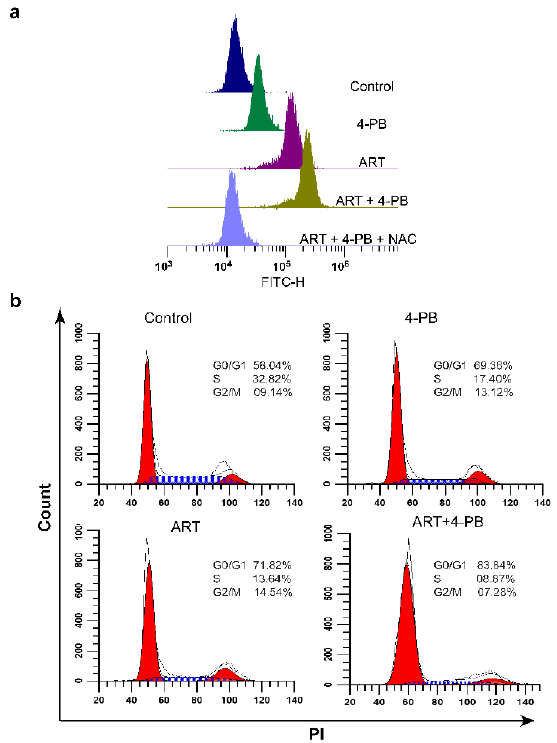
Figure 4. ROS generation and cell cycle analysis. ( a ) ROS generation in MCF-7 cells was examined by using DCFH-DA dye. The fluorescence level of DCF corresponds to the amount of ROS generated inside the cell. ( b ) The synchronised MCF-7 cells were treated with ART and/or 4-PB. After the end of the treatment duration, the phases of cell cycle were evaluated using PI dye. The data were acquired in the flow cytometer and analysed using ModFit LT software.